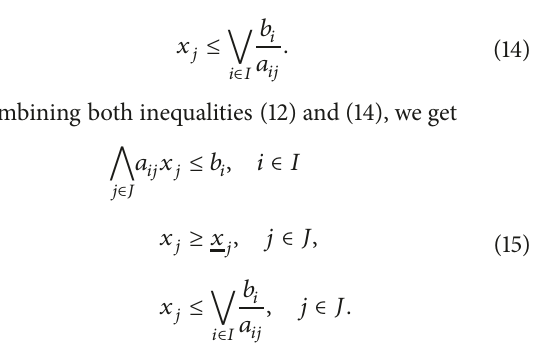
Figure 1: Supply chain system including 𝑛 suppliers and 𝑚